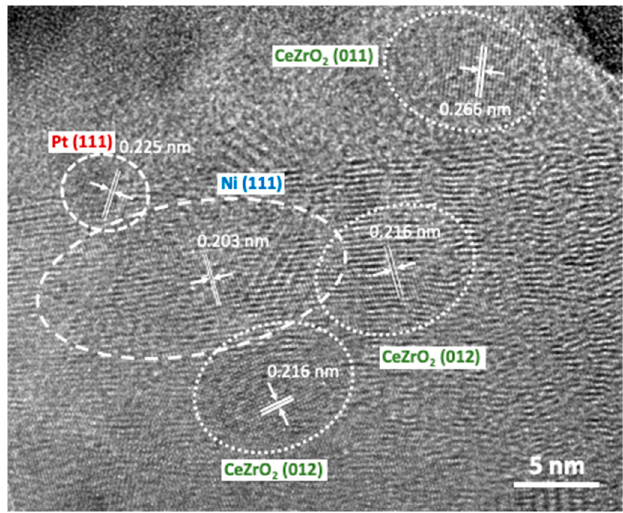
Figure 6. High-resolution TEM (HRTEM) of Pt-Ni-CZ/CFF sample. Table 2. Textural properties of CFF supported CeZrO 2 , Ni-CeZrO 2 , Pt-CeZrO 2 , Pt-Ni-CeZrO 2 catalysts. The specific surface area (SSA), total pore volume (V t ) and average pore diameter (d) of pristine carbon fibres (CF), oxidised carbon fibres (CFF) and CFF-supported catalysts Sample SSA (m 2 are presented in Table 2. As was expected, the SSA of carbon fibres increased after their oxidation in HNO 3 (from 26 m 2 /g for CF to 100 m 2 /g for CFF). Whereas deposition of the active phases over CFF resulted in partial coverage of its surface and blockage of pores, with the highest content of the active phase, i.e., Pt-Ni-CZ/CFF, whose BET surface area